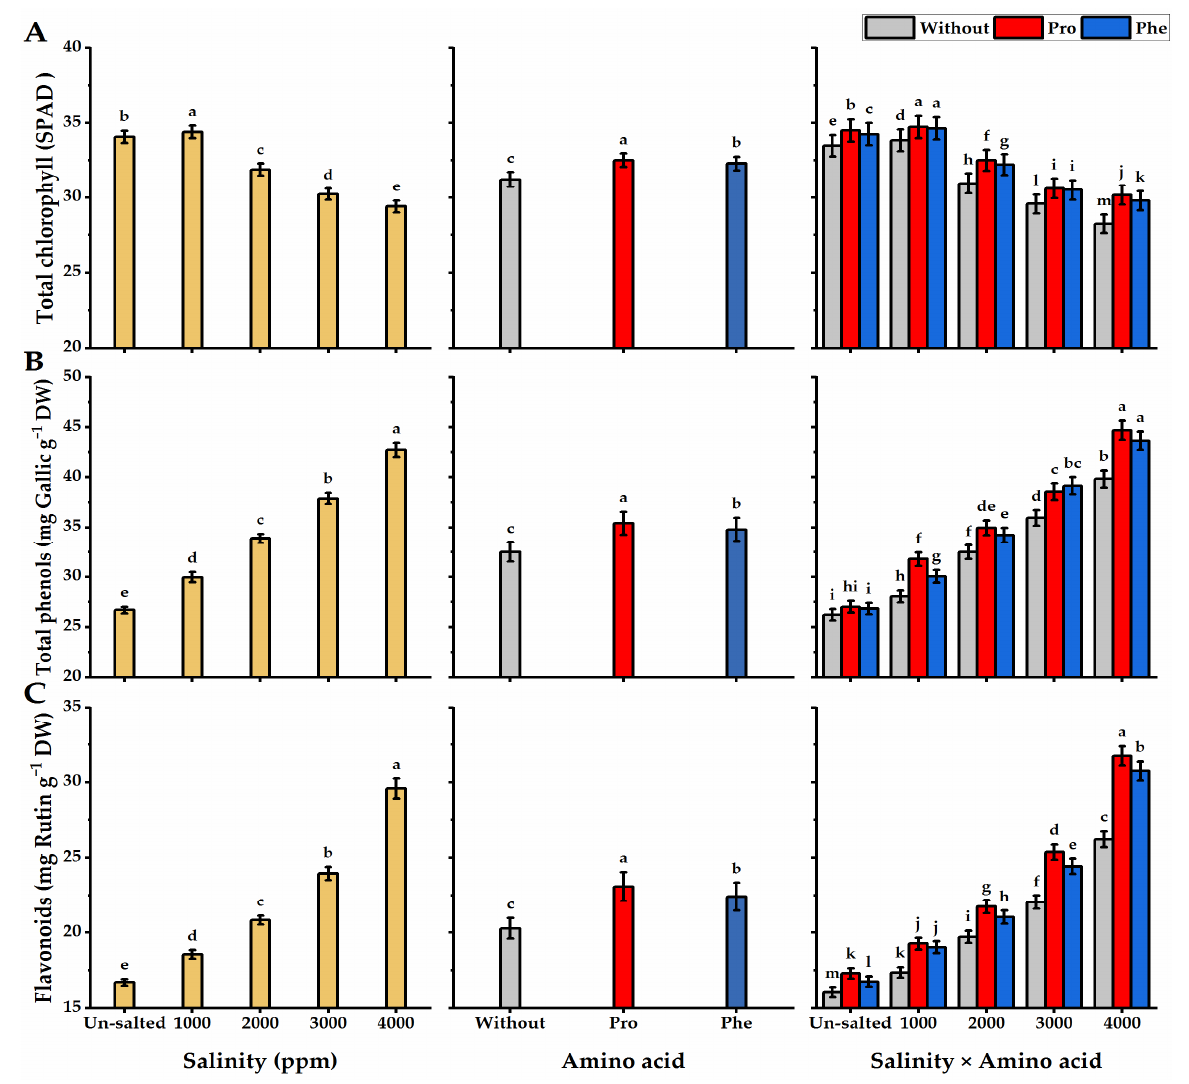
Figure 5. Influence of exogenous spray treatments of proline (Pro) or phenylalanine (Phe) on ( A ) total chlorophyll, ( B ) total phenols, and ( C ) flavonoids content of moringa leaves cultivated under different levels of salinity. Data are mean value ± SE. Bars with different letters are significantly different at p ≤ 0.05 level.